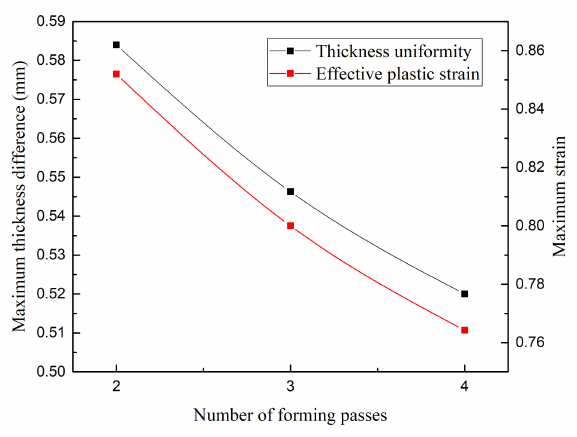
Figure 12. E ff ect of the number of forming